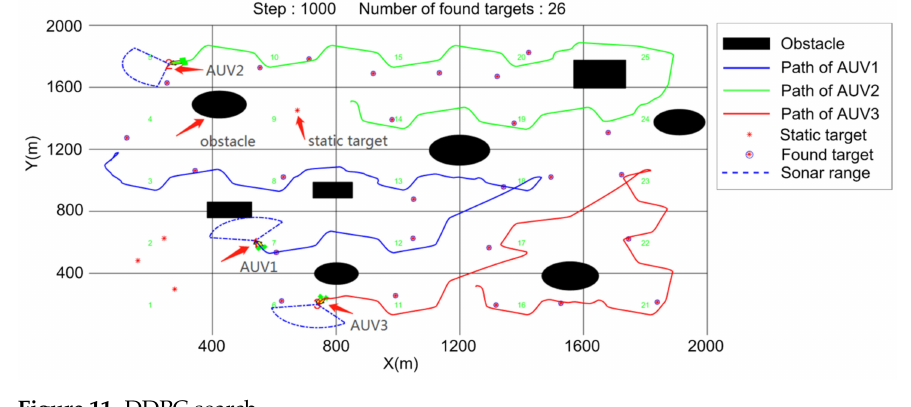
Figure 11. DDPC search.